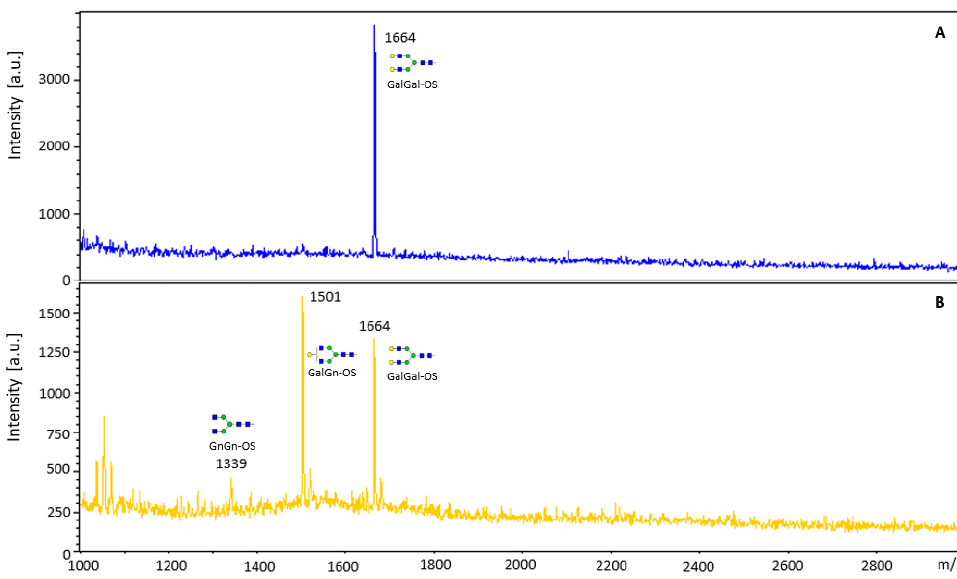
Figure 4. MALDI-TOF analysis of the release of galactose from GalGal-OS using the recombinant β -galactosidase from A. vulgaris. ( A ) GalGal-OS substrate; ( B ) GalGal-OS incubated with β -galactosidase.